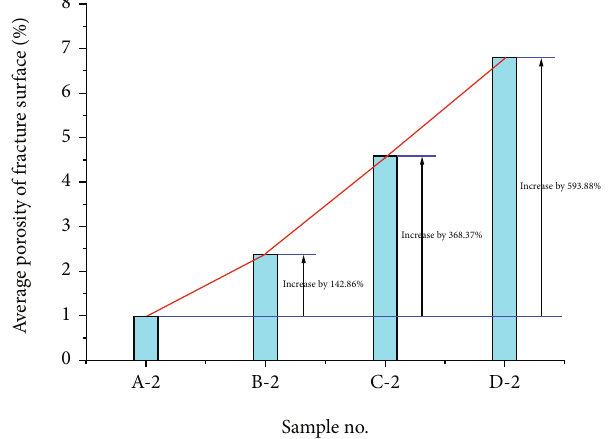
Sample no. Figure 13: Comparison of average porosities of sandstone sample fracture